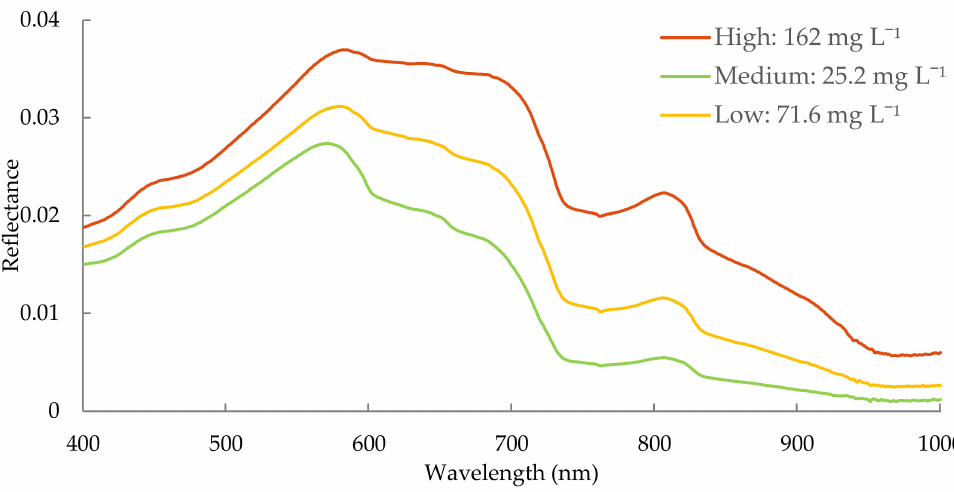
Figure 3. Spectral reflectance curve of turbid waters, reflectance changes with SSC